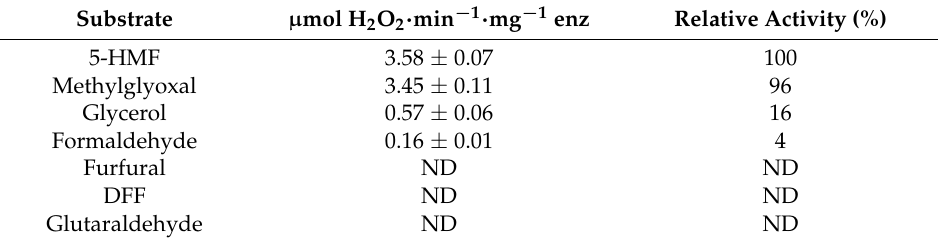
Table 1. Substrate specificity of Mt GLOx.